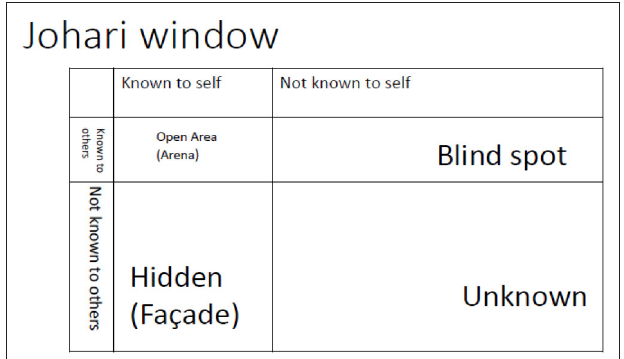
FIGURE 3 | Johari Window for a new tutee.